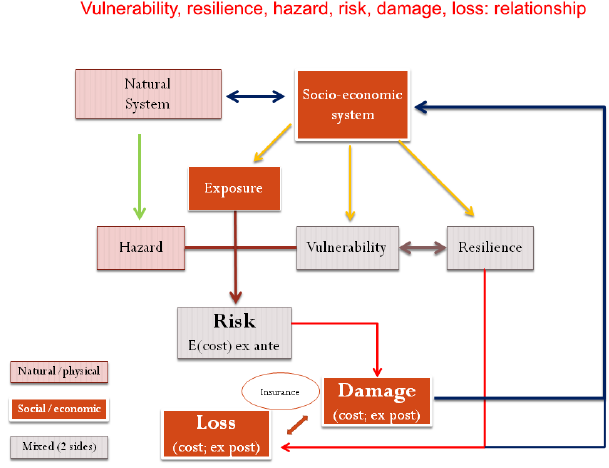
Figure 1. The socio-ecological framework for the evaluation of economic losses due to extreme